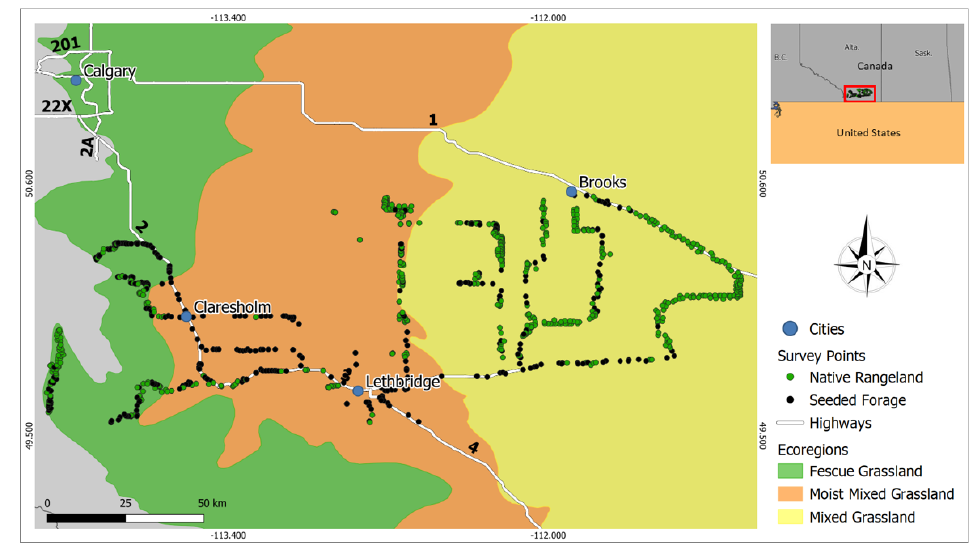
Figure 1. Study area of the three ecoregions and locations of survey points collected in July 2019.